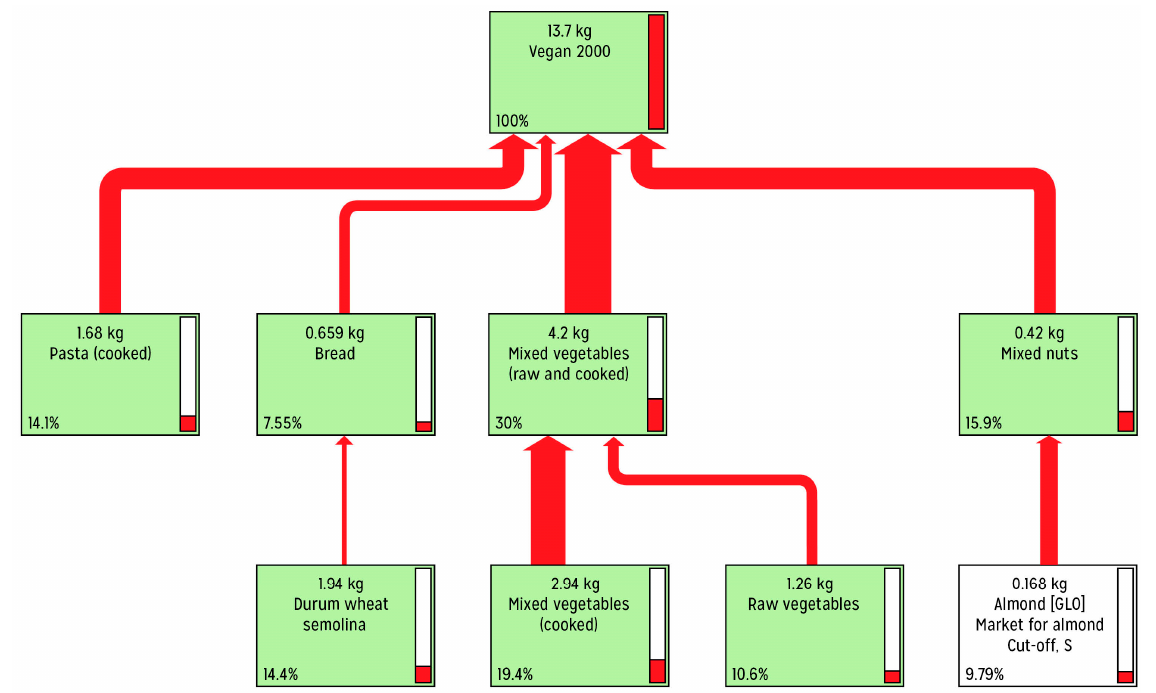
Figure A3. Vegan diet’s process contribution (tree). Functional unit: 1 week of Mediterranean diet foods (13.7 kg). Node cut-off: 7.5%, cumulative indicator as a percentage.